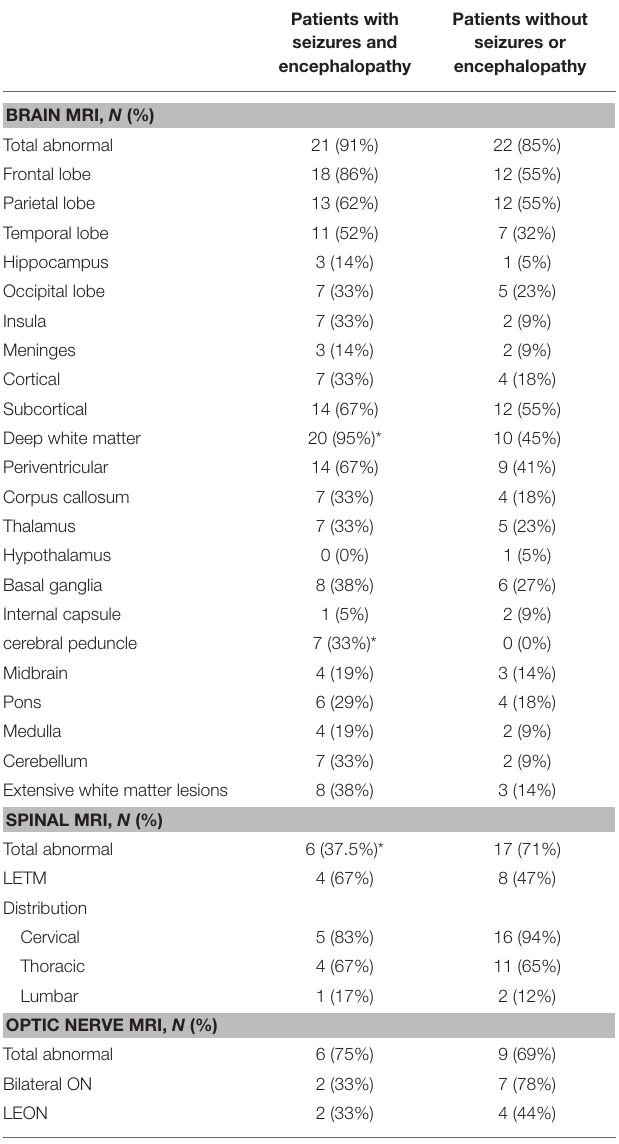
TABLE 4 | Comparison of MRI features between MOG-IgG positive patients with or without seizures and/or encephalopathy.